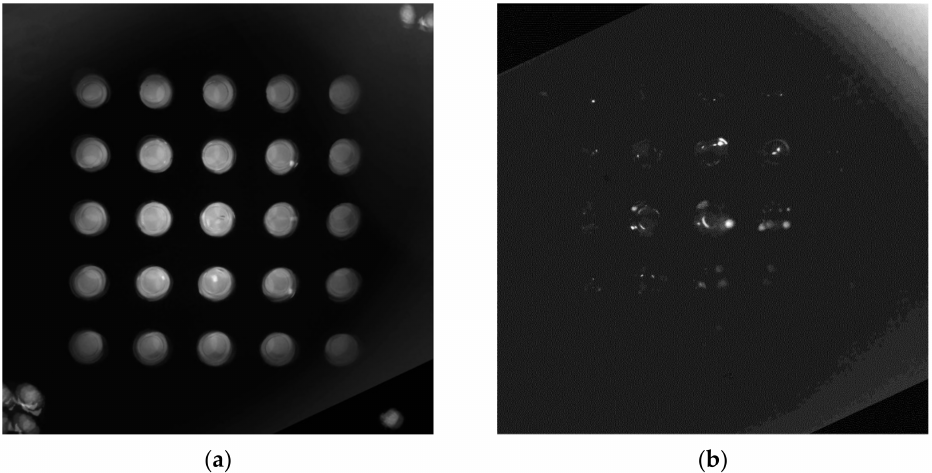
Figure 11. Image of combined from each quadrant into one: ( a ) FAM; ( b ) DDW (Increase by a factor of